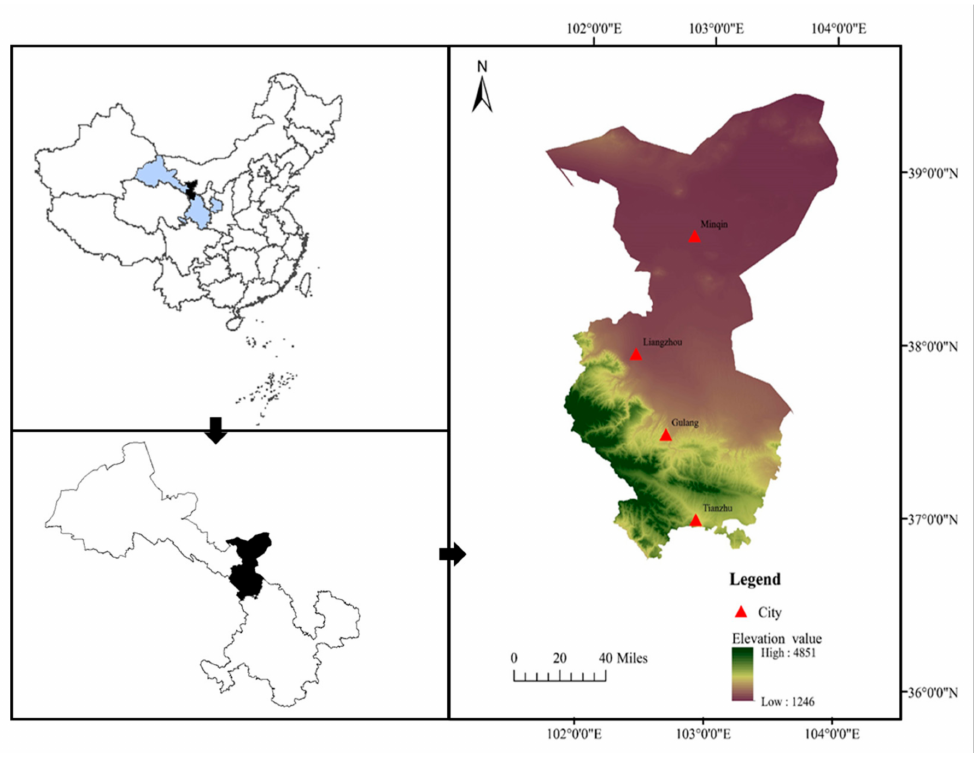
Figure 1. The study